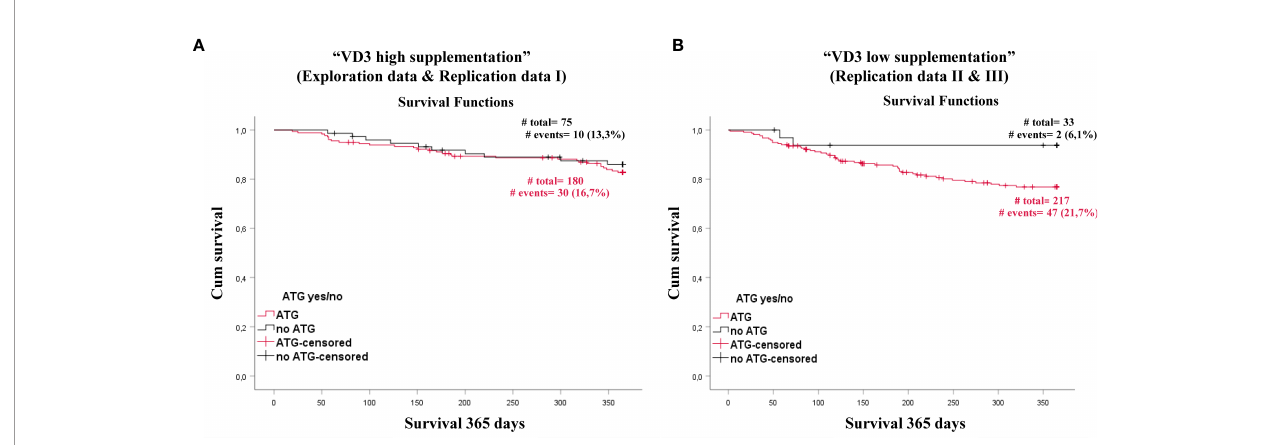
FIGURE 5 | ATG treatment impact on treatment related survival on vitamin D high or vitamin D low supplemented patients. Shown is a Kaplan- Meier curve comparing patients that received ATG (red) with patients that did not received ATG treatment (black) for patients receiving high vitamin D3 supplementation (A) and patients receiving no or low vitamin D3 supplementation (B) .